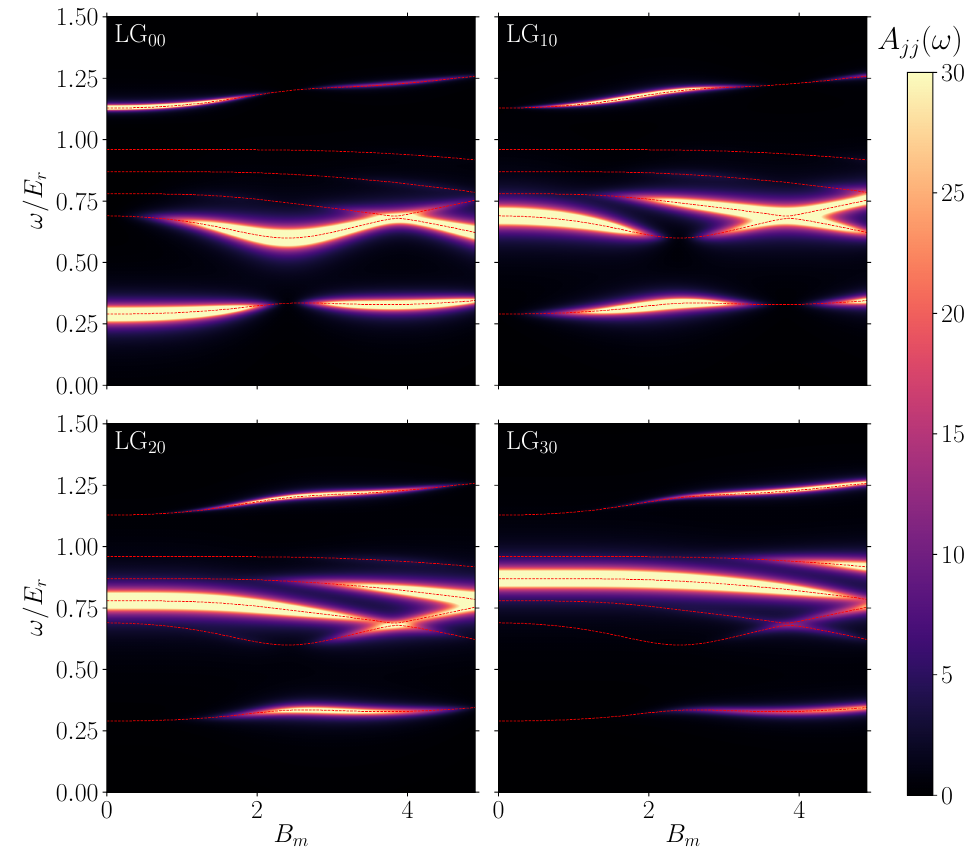
0 . 0 2 4 B m Figure 6: Distribution of the spectral weight as a function of the modulation am- plitude for different components of the cavity field, corresponding to the first four radial transverse modes LG with p ∈ { 0,1,2,3 } . The PM frequency is chosen pl such that the higher-order modes have a large effective detuning ( ε = − 0.09 E ) r ( B ) 2 , with the renormalized coupling strength defined in Eq. (15). and Λ 2 = 0.7 Λ c m ) 2 = 0.7 with a detuning These figures correspond to cuts through Fig. 4 at ( Λ / Λ c ∆ = 0.6 for the zeroth mode, while the remaining parameters are as in Fig. 4. 0 The red lines are poles of the real part of the cavity Green’s function in Eq. (11) and therefore indicate the polariton